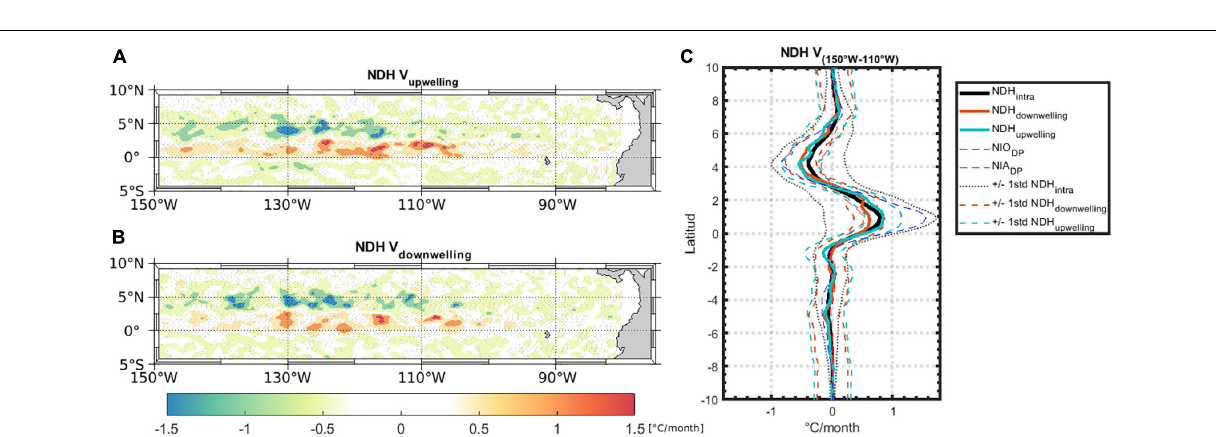
FIGURE 5 | Composites of meridional components of intraseasonal Non-linear Dynamical Heating (NDH) during upwelling (A) and downwelling (B) IKWs events identified in Figure 2A . (C) Longitudinal average (between 150 and 110 ◦ W) of intraseasonal NDH annual mean (thick black line), IKWs upwelling phases (thick turquoise line), IKWs downwelling phases (thick brown line), interannual El Niño (dashed red line) and La Niña (dashed blue line) developing phase (July–November) NDH composite. The thin black (orange/turquoise) dashed lines indicate ± 1 standard deviation of the total intraseasonal NDH (amongst the downwelling/upwelling events). Units are ◦ C/month.